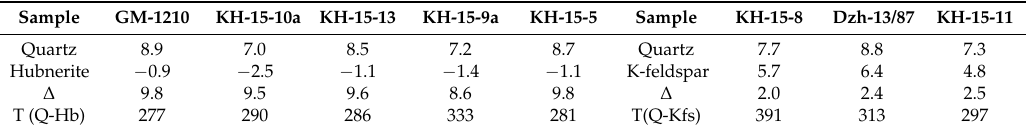
Table 3. Temperatures calculated and δ 18 O values in coexisting mineral pairs from the Kholtoson